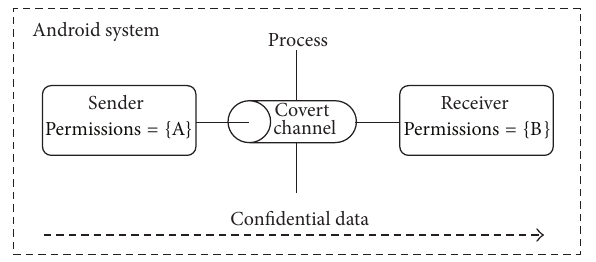
Figure 1: General model of Android covert